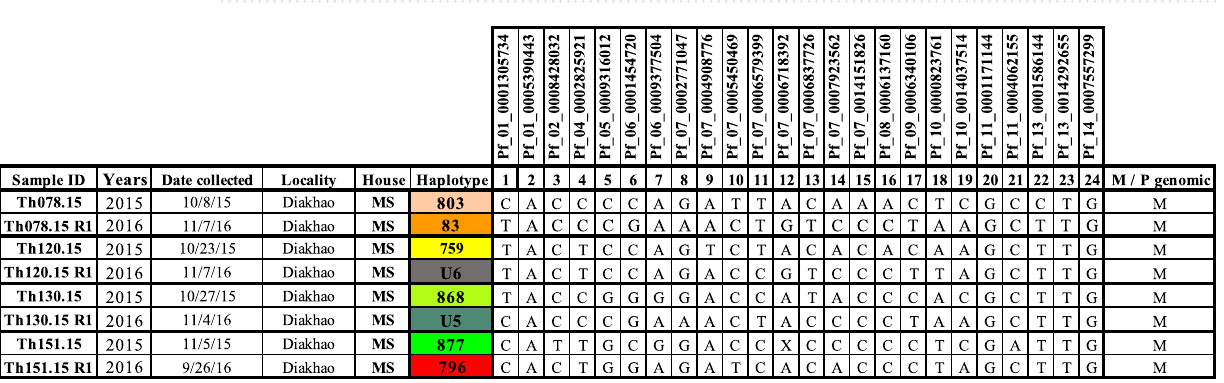
Figure 3. Hotspots of malaria transmission by neighborhood and household. Map of sample locations by household (BD, BS, DL, DMS, GB, MS, OB, OD, SD and SN), and neighborhood (Cité Senghor, Diakhao, Escale, Nguinth, Thialy and Takhikao) from 2014 to 2017. Legend indicates and the parasite barcode haplotype ID and is color-coded by haplotype. The size of the circle is proportional to the number of samples in the haplotype, as indicated in the scale. Solid lines indicate delineation of the neighborhoods.